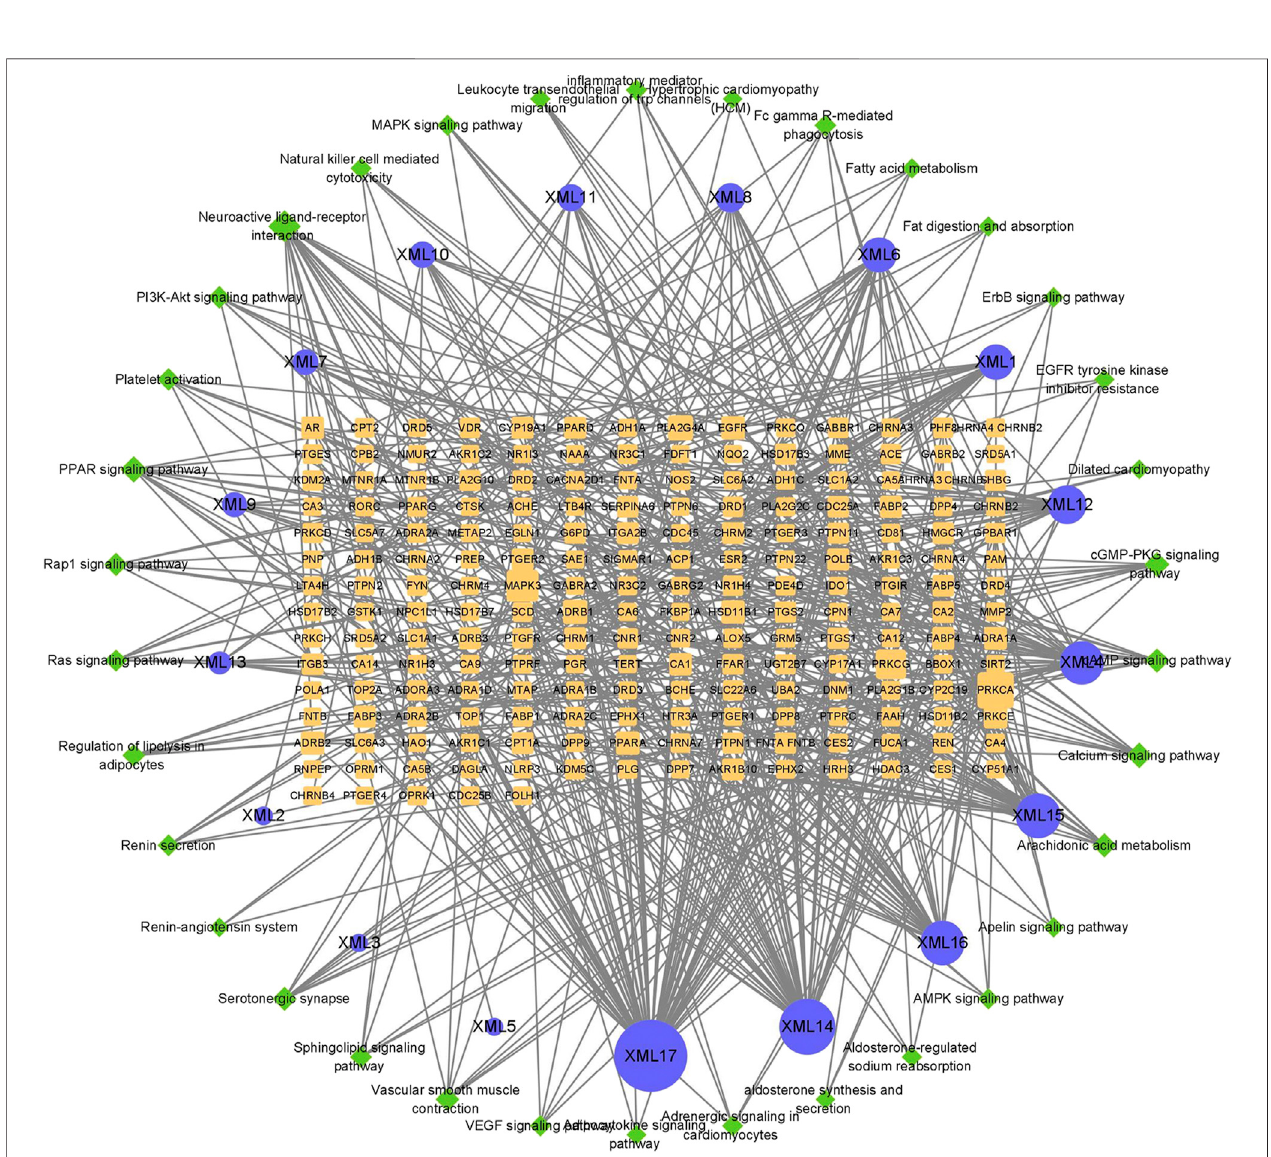
FIGURE 4 | XML ingredient-target-pathway network. Blue circles represent active components, yellow rectangles represent target genes, and green diamonds represent pathways. The size of a node represents its degree. The larger the area, the more important the node.